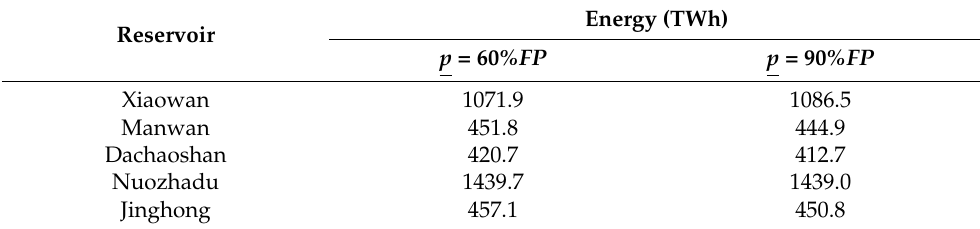
Table 4. Energy generation using